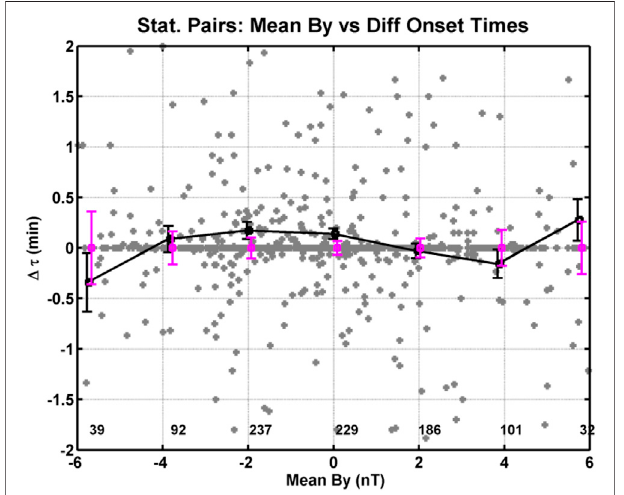
FIGURE 6 | Format of this fi gure is the same as Figure 5 , except for this fi gure we have excluded differences in onset time equal to 0 s.